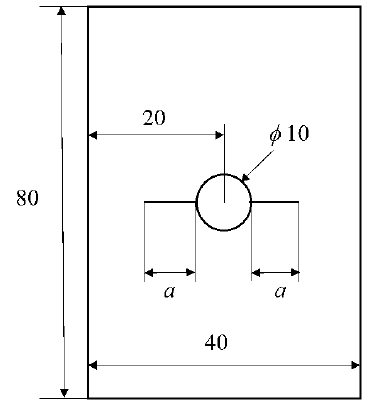
Figure 7. Single-hole plate geometry